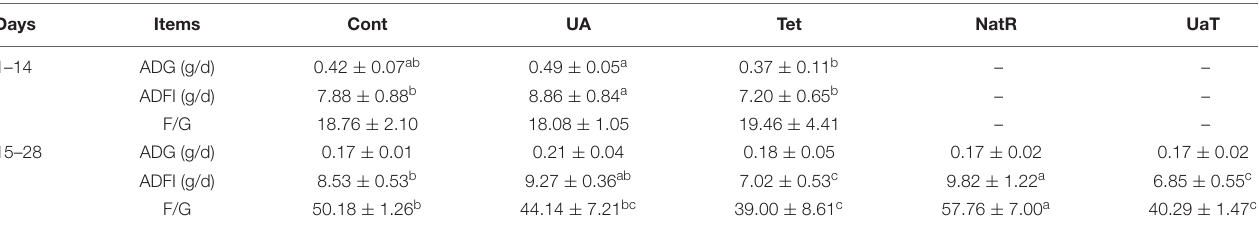
TABLE 2 | Effects of ursolic acid and chlortetracycline on mice average daily gain (ADG), average daily food intake (ADFI), and feed-to-gain ratio